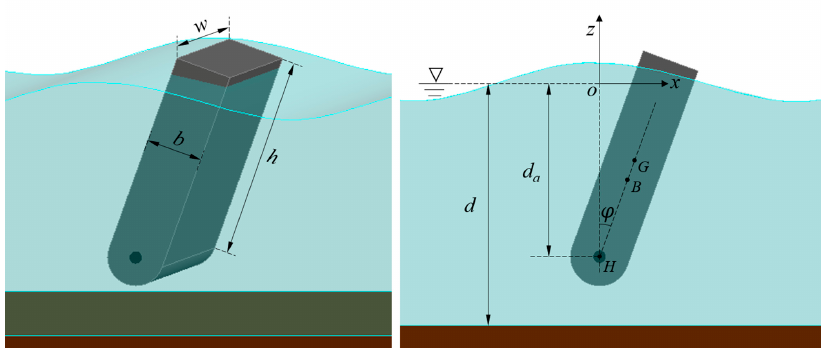
Figure 1. An illustration of a 3D bottom-hinged oscillating wave surge converter.